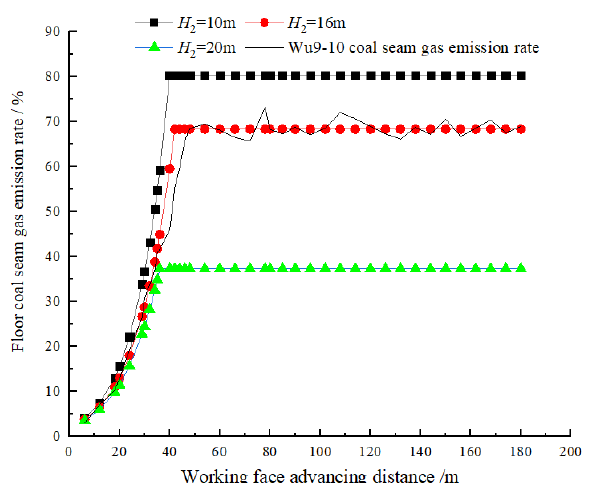
Figure 11. Variation of the gas emission rate of lower adjacent coal seams with the advancing dis- tance of the working face.